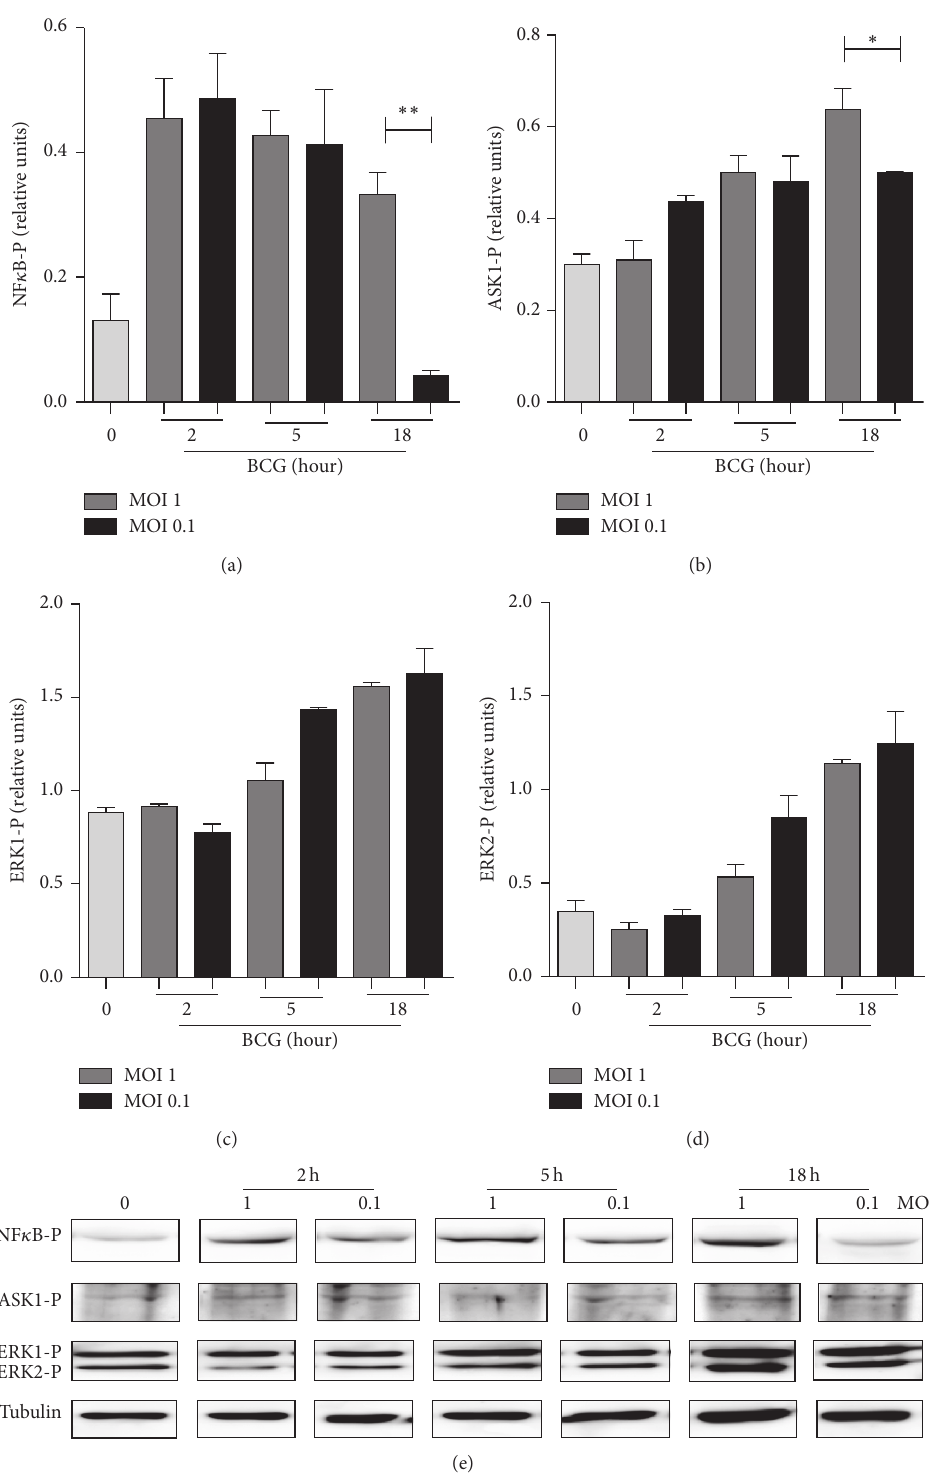
Figure 4: BCG infection at MOI 1 and MOI 0.1 activates NF 𝜅 B and MAPK pathways. (a) Phosphorylated forms of NF 𝜅 B, (b) ASK, (c) ERK1, and (d) ERK2 were evaluated by western blot analyses. Band densities were normalized against tubulin by densitometry analyses. (e) Representative western blot from three independent experiments. Results are shown in relative units of concentration using IMAGEJ software. Two-tailed unpaired Student’s 𝑡 -test was used to evaluate statistical differences. Bars indicate mean ± SEM. ∗∗ 𝑃 < 0.01 ; ∗ 𝑃 < 0.05 . Light grey bar indicates uninfected cells